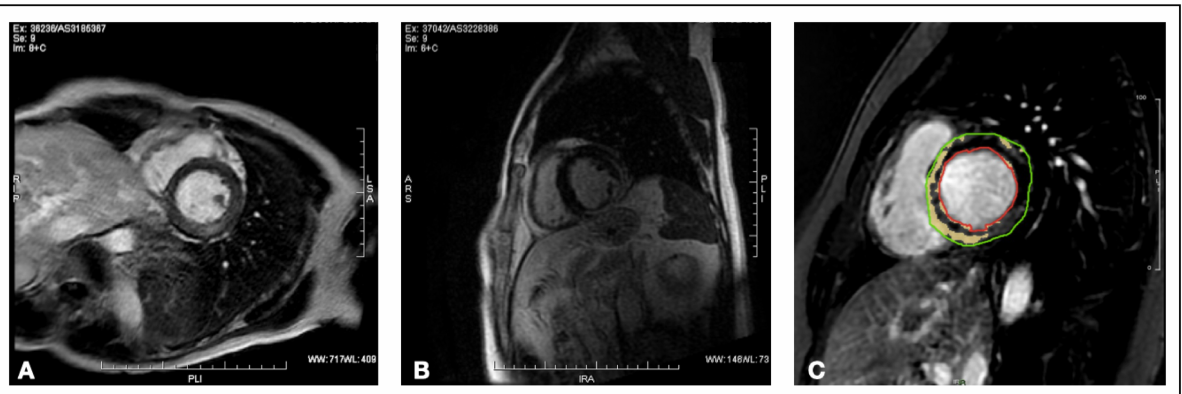
Figure 1. T1-weighted cardiac magnetic resonance short-axis of patients with different degrees of delayed enhancement. ( A ) Patient with mild presence of delayed gadolinium enhancement. ( B ) Patient with diffuse, sub-epicardial and mid-wall localization of delayed gadolinium enhancement. ( C ) Late gadolinium enhancement mass quantification technique. The green circle represents the sub-epicardial layers of myocardium, the red circle represents the sub-endocardial layers.